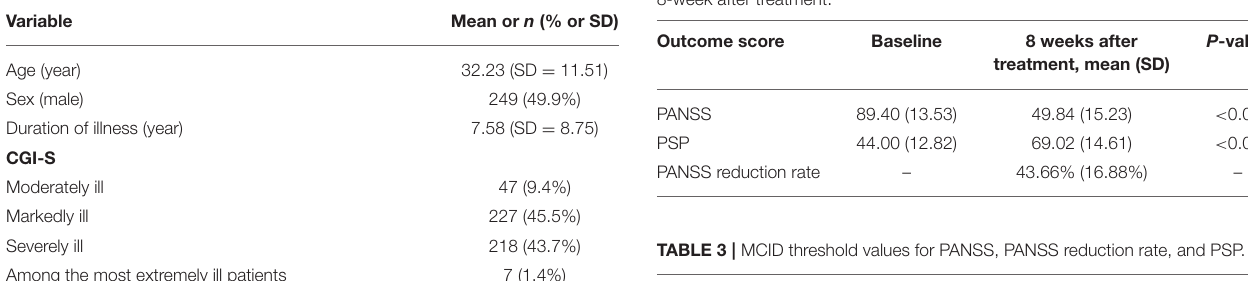
TABLE 1 | Demographic characteristics of participants. TABLE 2 | Outcomes (PANSS, PSP, and PANSS reduction rate) at baseline and 8-week after treatment.